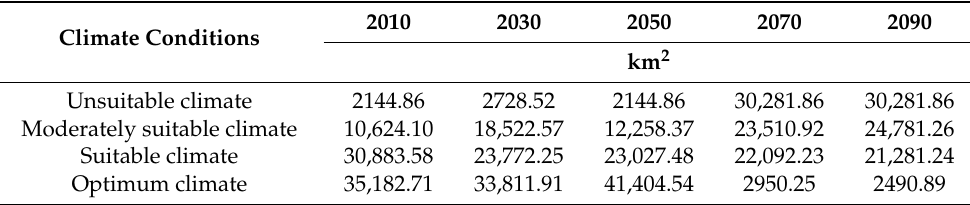
Table 2. Current state and prediction of the climate conditions for European beech in the Czech Republic (forecast period 2030, 2050, 2070, and 2090 year).